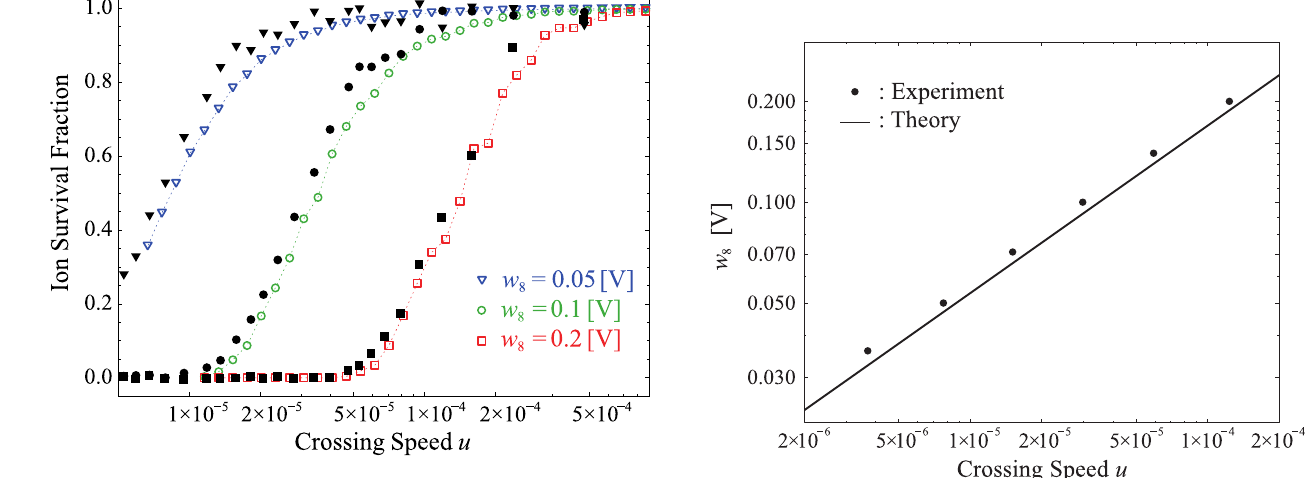
FIG. 9. Crossing-speed dependence of the critical perturbation voltage at which the maximum transverse shift of the plasma centroid reaches 5 mm (the LPT aperture) after single resonance crossing at ν 0 ¼ 8 . The solid curve is a theoretical estimate with the nonsmooth formula. Black dots are experimental data from